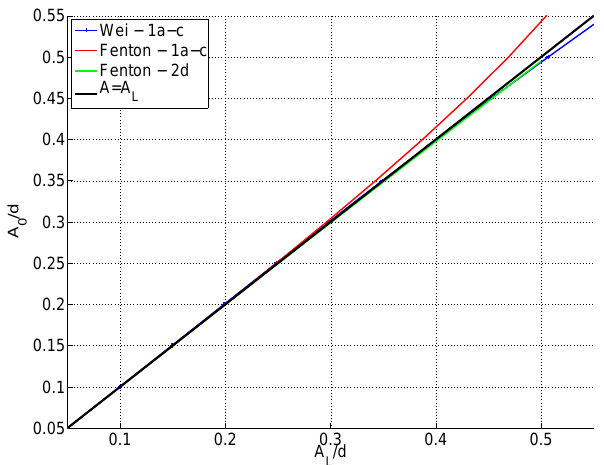
Fig. 1. Initial solitary wave amplitude as a function of the amplitude after a propagation distance of x/d = 30. The very close agreement between two of the curves is presumably a coincidence.